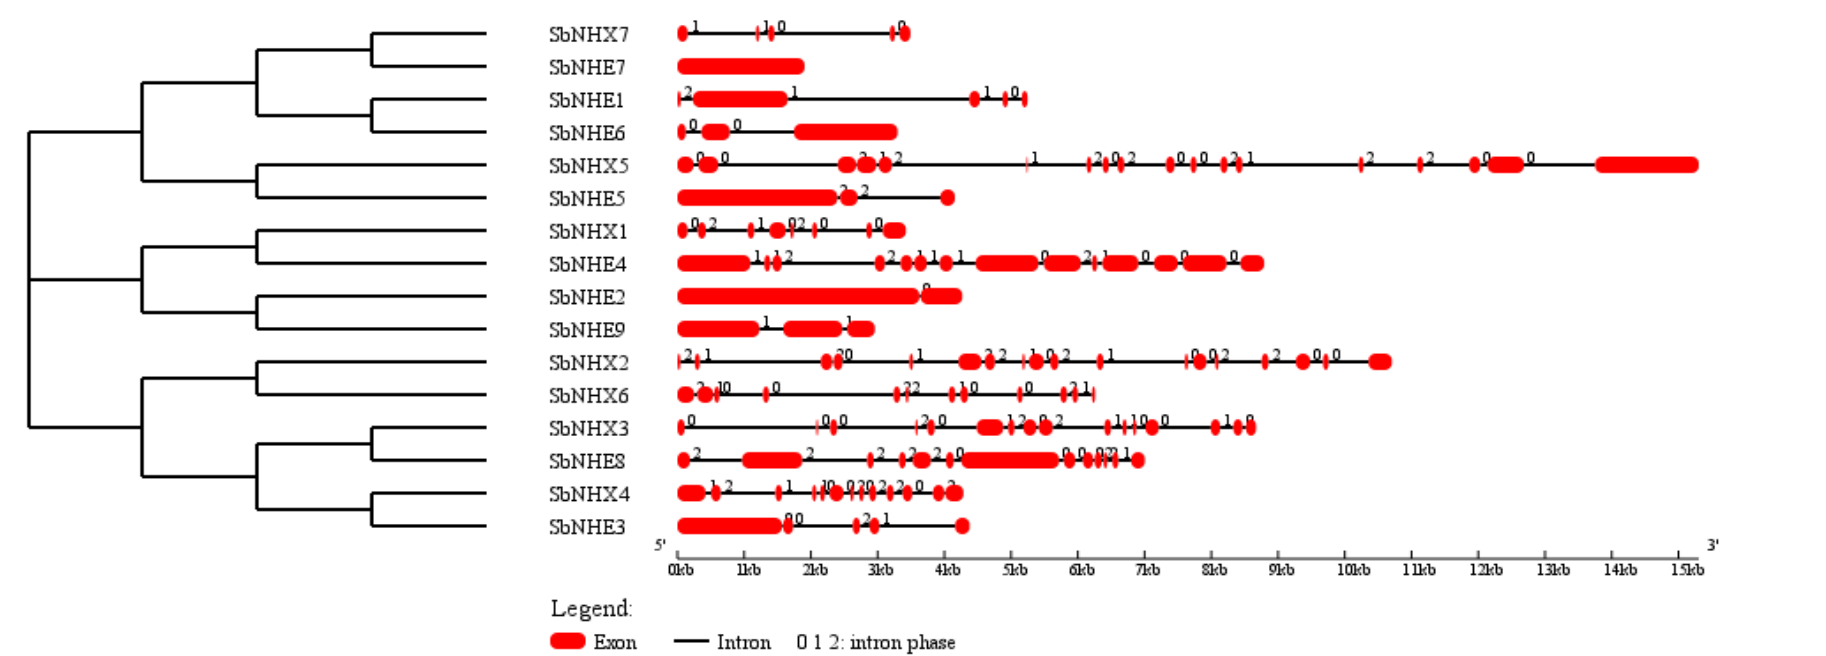
Figure 1. Gene characterization of sodium transporters. Exons are represented as red boxes and introns as black lines. Intron phases 0, 1, and 2 are indicated by the numbers 0, 1, and 2.